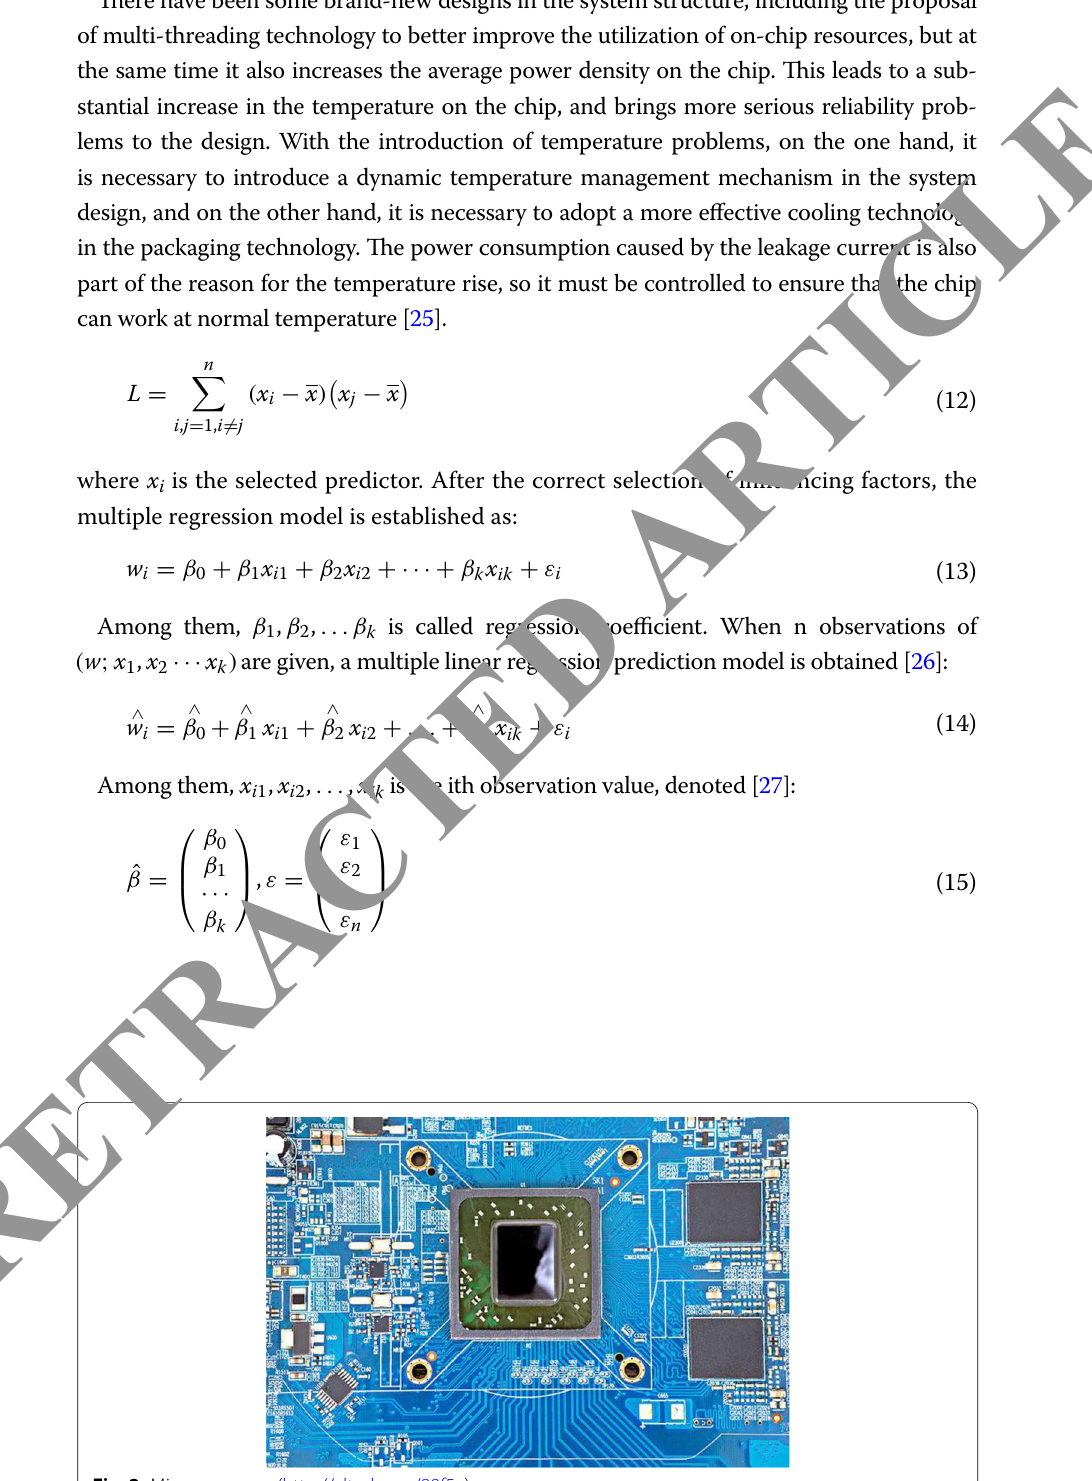
Fig. 2 Microprocessor (http:// alturl. com/ 89f5e)